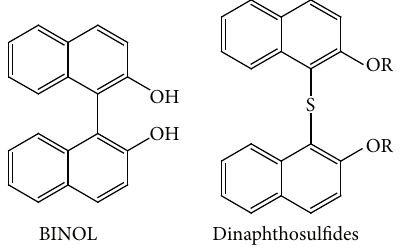
F 1: e structure of BINOL and dinaphthyl